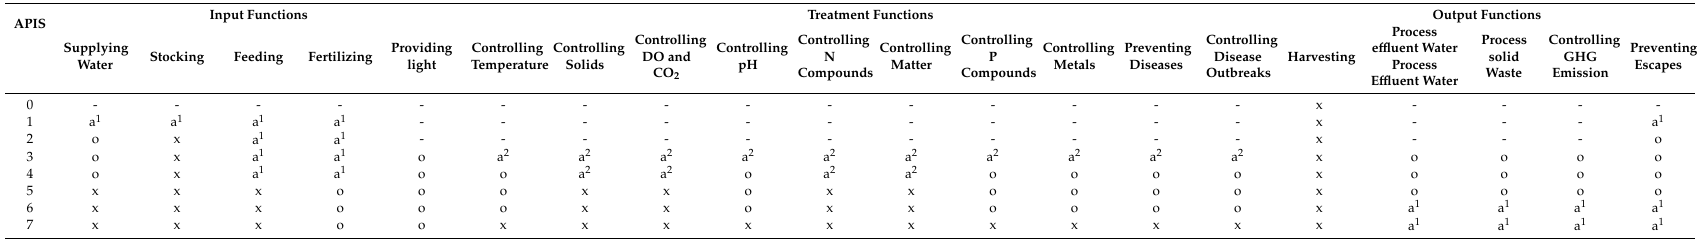
Table 2. Mapping of functions to APIS level (legend: ‘-‘ = not possible, x = required, a n = at least one from group n and o =